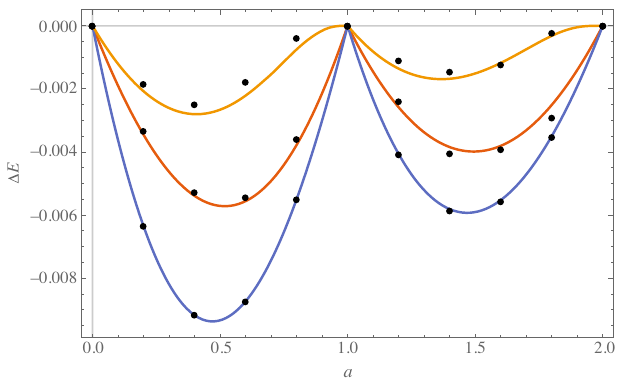
FIG. 16. The energy excess Δ E ¼ yf ð q 0 Þ − β f ð q 12 Þ as a function of a , for the approximate solution of the same models as in Fig. 14. The three curves correspond to the a -dependent 0 . 1 T temperatures T (blue), T (red), and 0 . 9 T SF MCT MCT þ onset (orange). We see that Δ E → 0 in the limit of pure models with no discontinuity, while Δ E < 0 in general mixed models. The points are extrapolated values from the numerical integration of the dynamical equations; the comparison shows good agreement at all